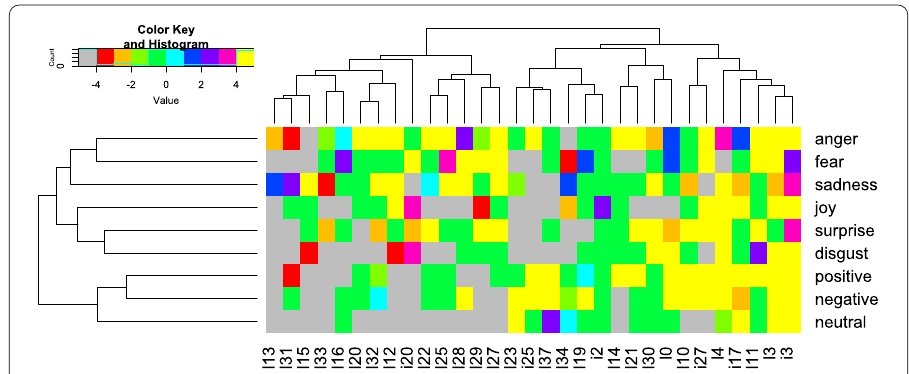
Figure 6 The lead and lag intervals in weeks for ILI-Affect cross-correlations across 31 military locations. Cells of different colors represent lagging (+) vs. leading (–) intervals between 0 and 4 (or more) weeks for statistically significant cross-correlation results ( p -value ≤ 0.05, 95% confidence interval). Locations (columns) and affects (rows) are reordered by similarity using the Euclidean distance measure and are shown as a